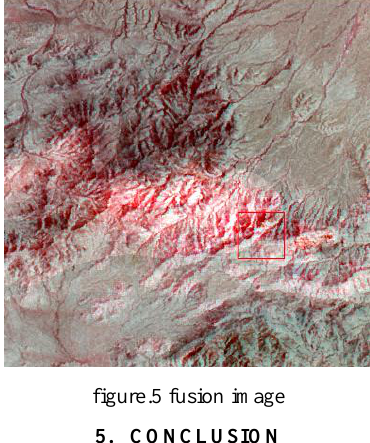
figure3. Remote sensing alteration image